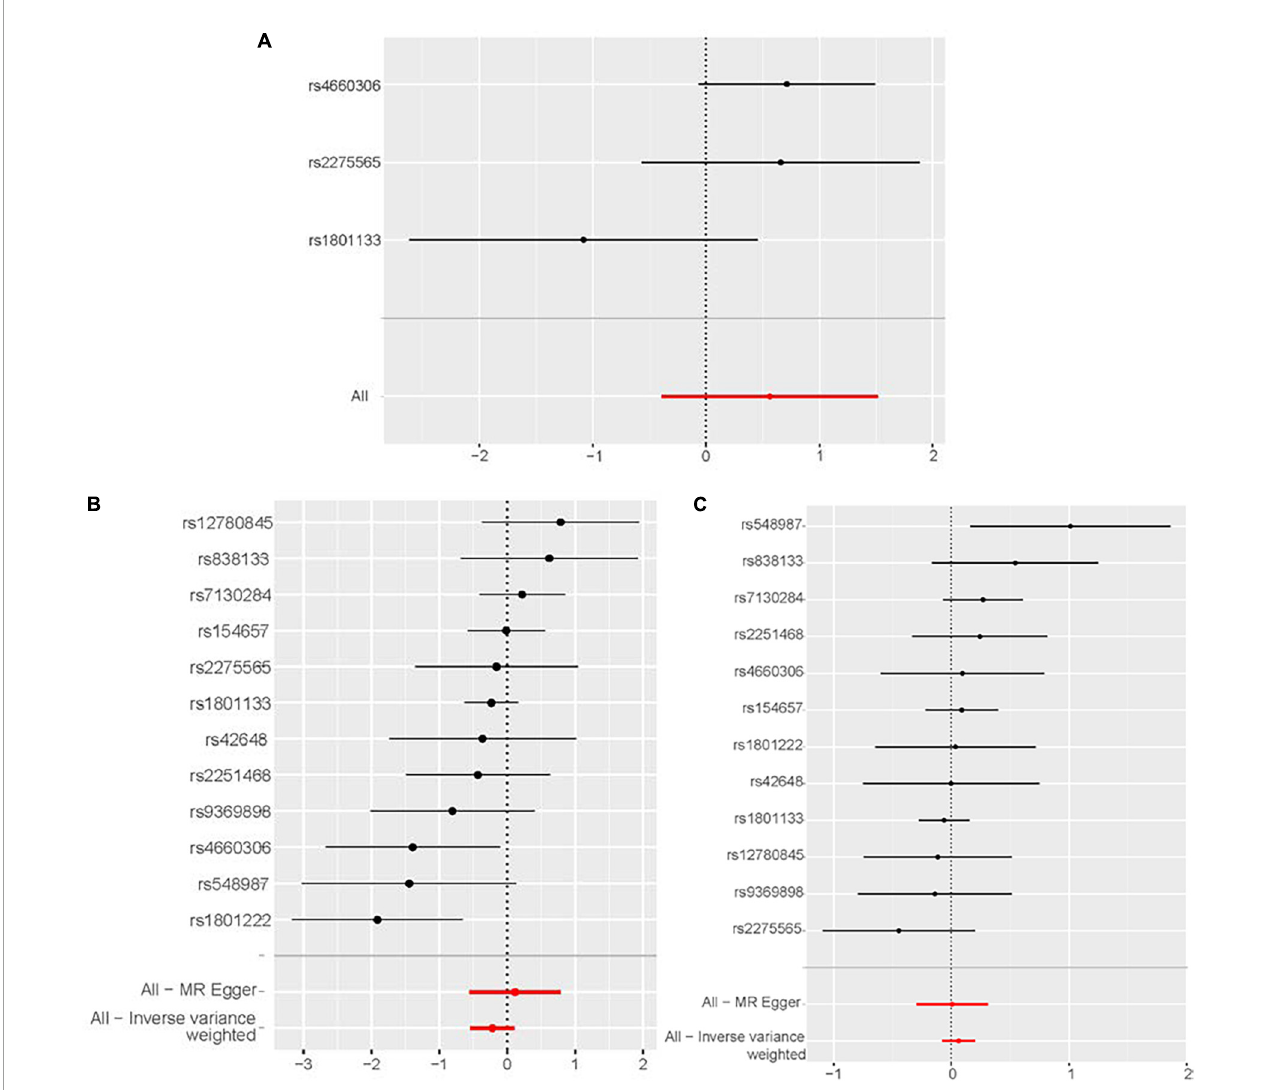
FIGURE5 Sensitivity analyses using the leave-one-out approach for the association of plasma homocysteine level with outcomes. (A) Congestive heart failure. (B) Cardiomyopathy. (C) Non-ischemic cardiomyopathy. CI, confidence interval; IVW, inverse variance-weighted; MR, Mendelian